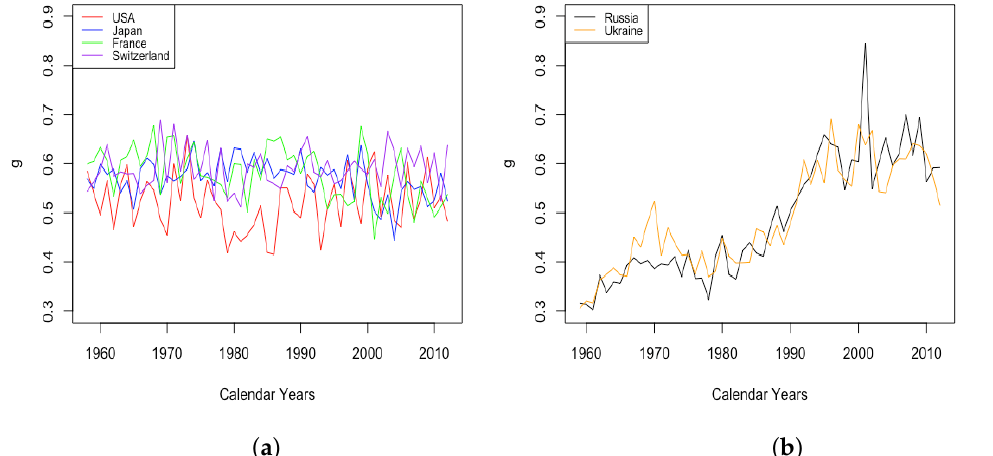
Figure 8. ( a ) Limiting old age mortality g across HLE countries. ( b ) Limiting old age mortality g across ILE countries.